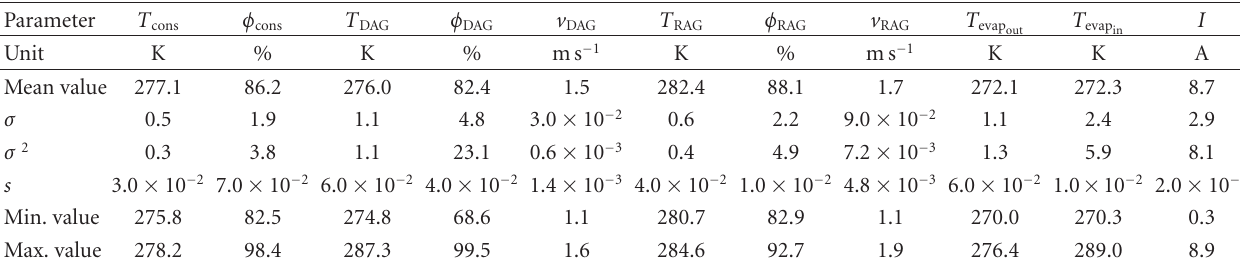
Table 2: Experimental average results for climatic class n. ◦ 3-EN-ISO std.